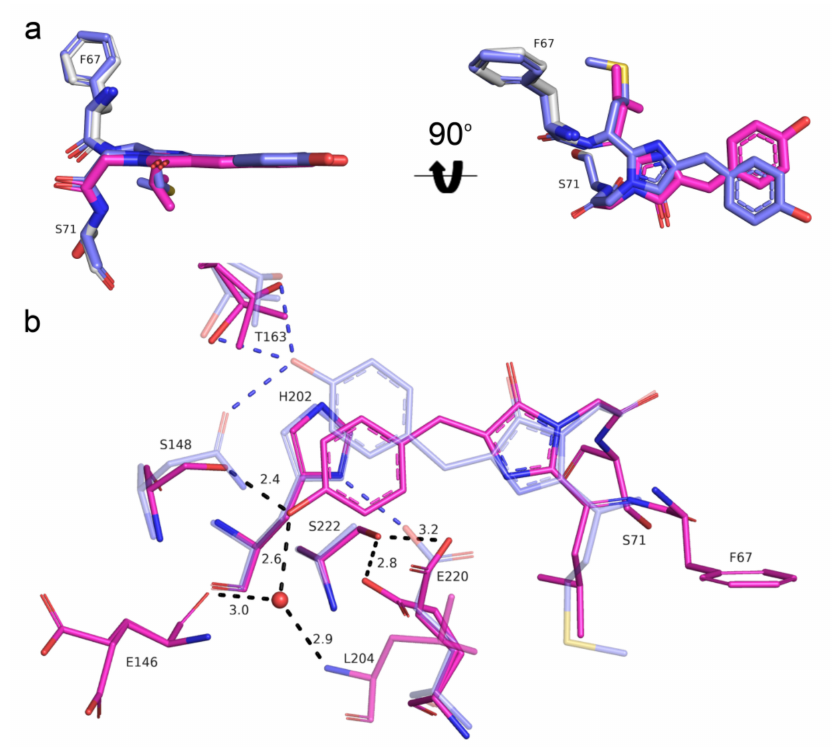
Figure 7. Structural comparison of the chromophores ( a ) and their immediate environments ( b ) for the red form of the mRubyFT timer (pink) and mRuby (PDB ID: 3U0M, blue) protein. Water molecule (red sphere) and hydrogen bonds (dashed lines) are shown. Hydrogen bond distances are only labelled for mRubyFT for clarity. Residues’ enumeration is shown for the mRubyFT protein. In panel ( a ), the orientation of the chromophore on the right is rotated 90 ◦ around the horizontal axis with respect to that on the